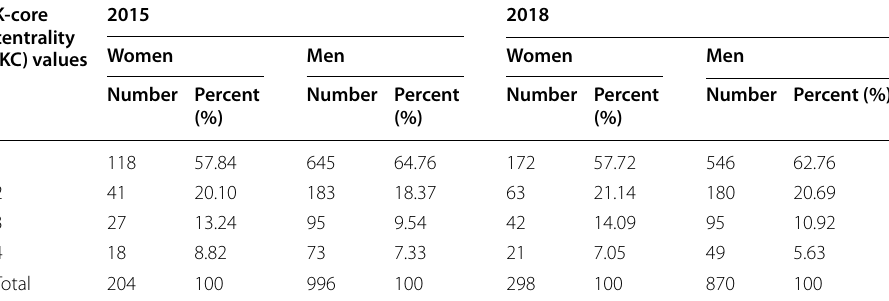
Table 4 K-core centrality values by gender (2015 and 2018) K‑core centrality (KC) values